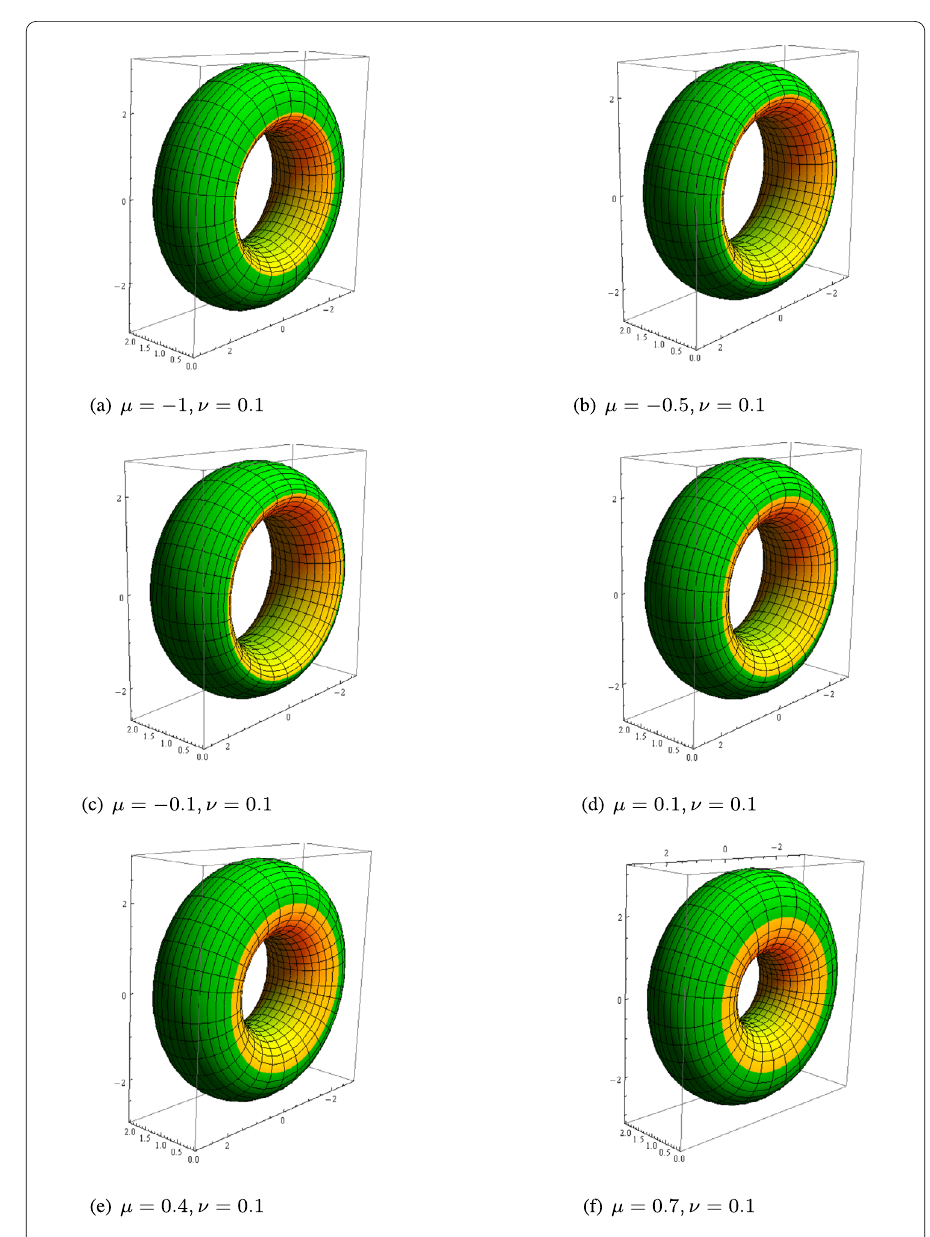
Figure 24 GBT-Bézier rotating ring surfaces along various values of shape parameters